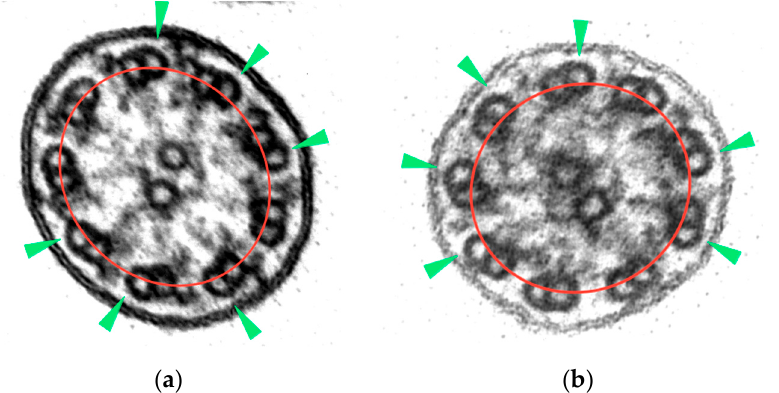
Figure 2. Axonemal symmetry break: ( a ) rotating doublets of ciliary section without apparent axonemal defects; ( b ) rotating doublets of ciliary section with absence of ODAs. B-tubules (green arrowheads) are outside the axonemal circumference (red line) (micrographs, original magnification × 530,000).